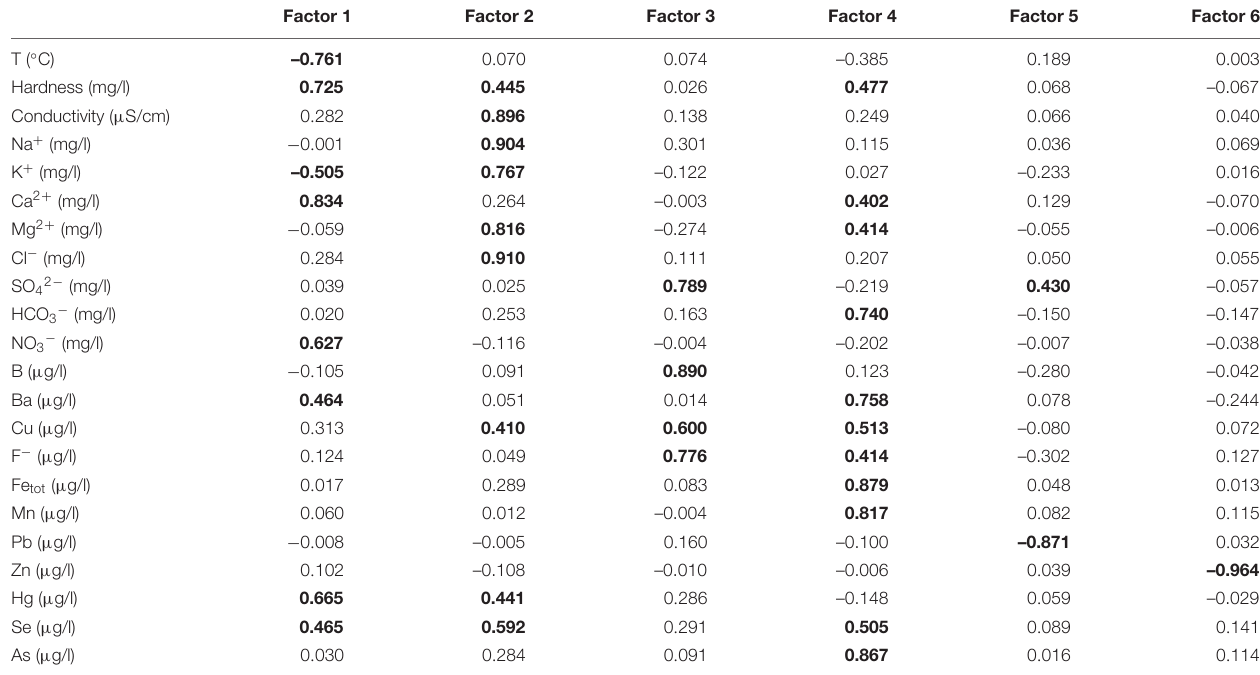
TABLE 1 | Factors extracted from the PCA for the parameters